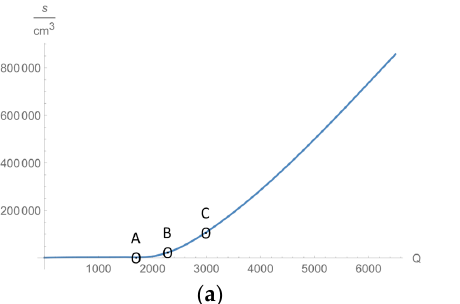
Figure 3. Comparison between measurements and simulation of the dynamical optical responses of an OLED under a peak current density of 0.462 kA/cm 2 . In ( a ) the measured current and the simulated polaron density are depicted, in ( b ) the simulated host singlet and triplet densities and in ( c ) the dopant excitons. In ( d ) the measured (red curve) and simulated (black curve) photon densities (right scale) are shown together with the amplification rate (10) (blue curve; left scale). Parameters used in the simulation are given in Table 1, except for those given in Table 2. The dashed black curve in ( d ) is the simulated photon density for the zero-voltage value γ = 6.2 × 10 − 12 cm 3 s − 1 .